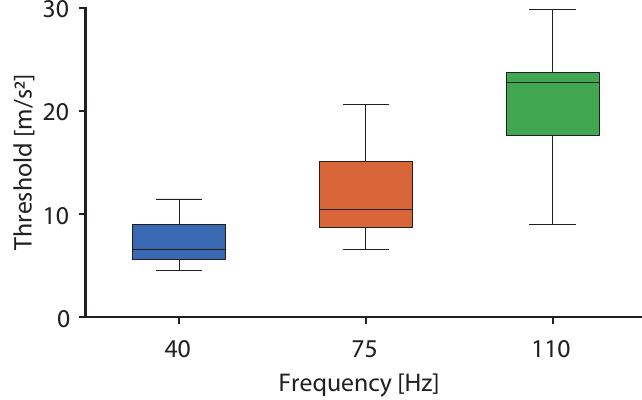
Figure 8. Thresholds of illusion occurrences at different